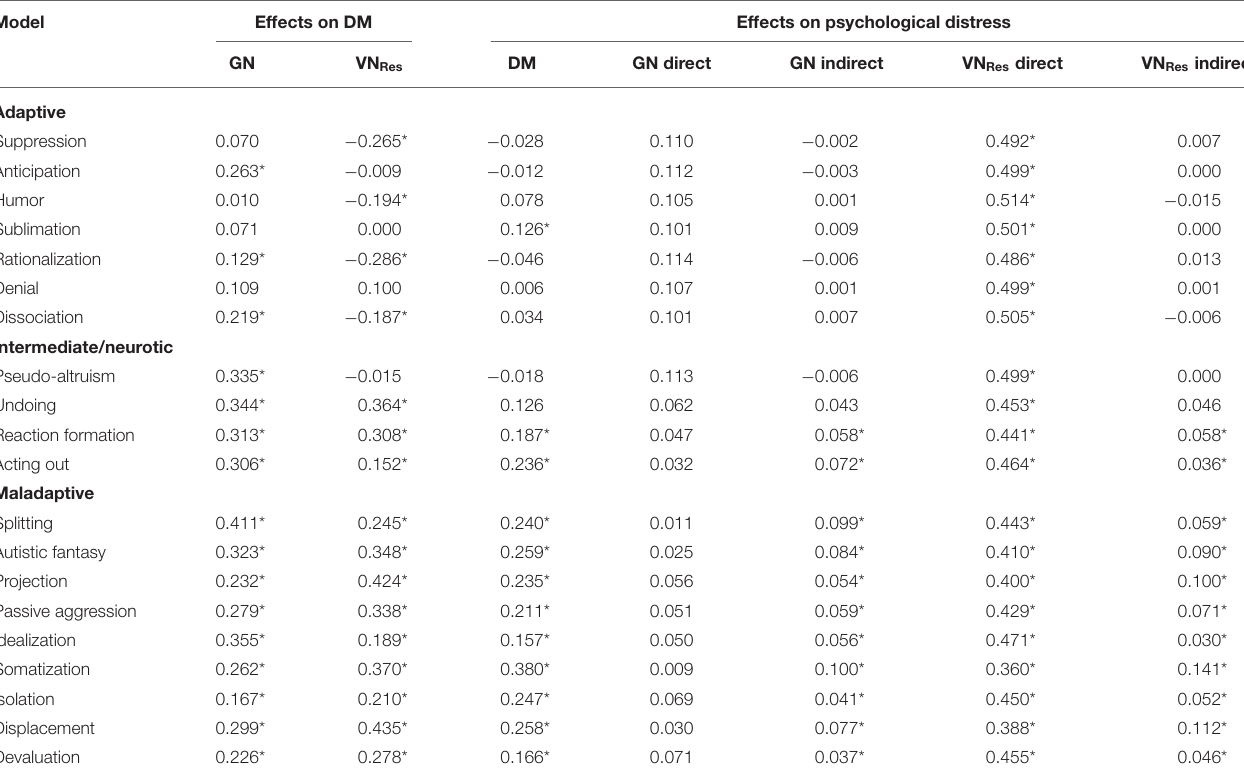
TABLE 2 | Direct and indirect effects of narcissism on psychological distress mediated by defense mechanisms. Model